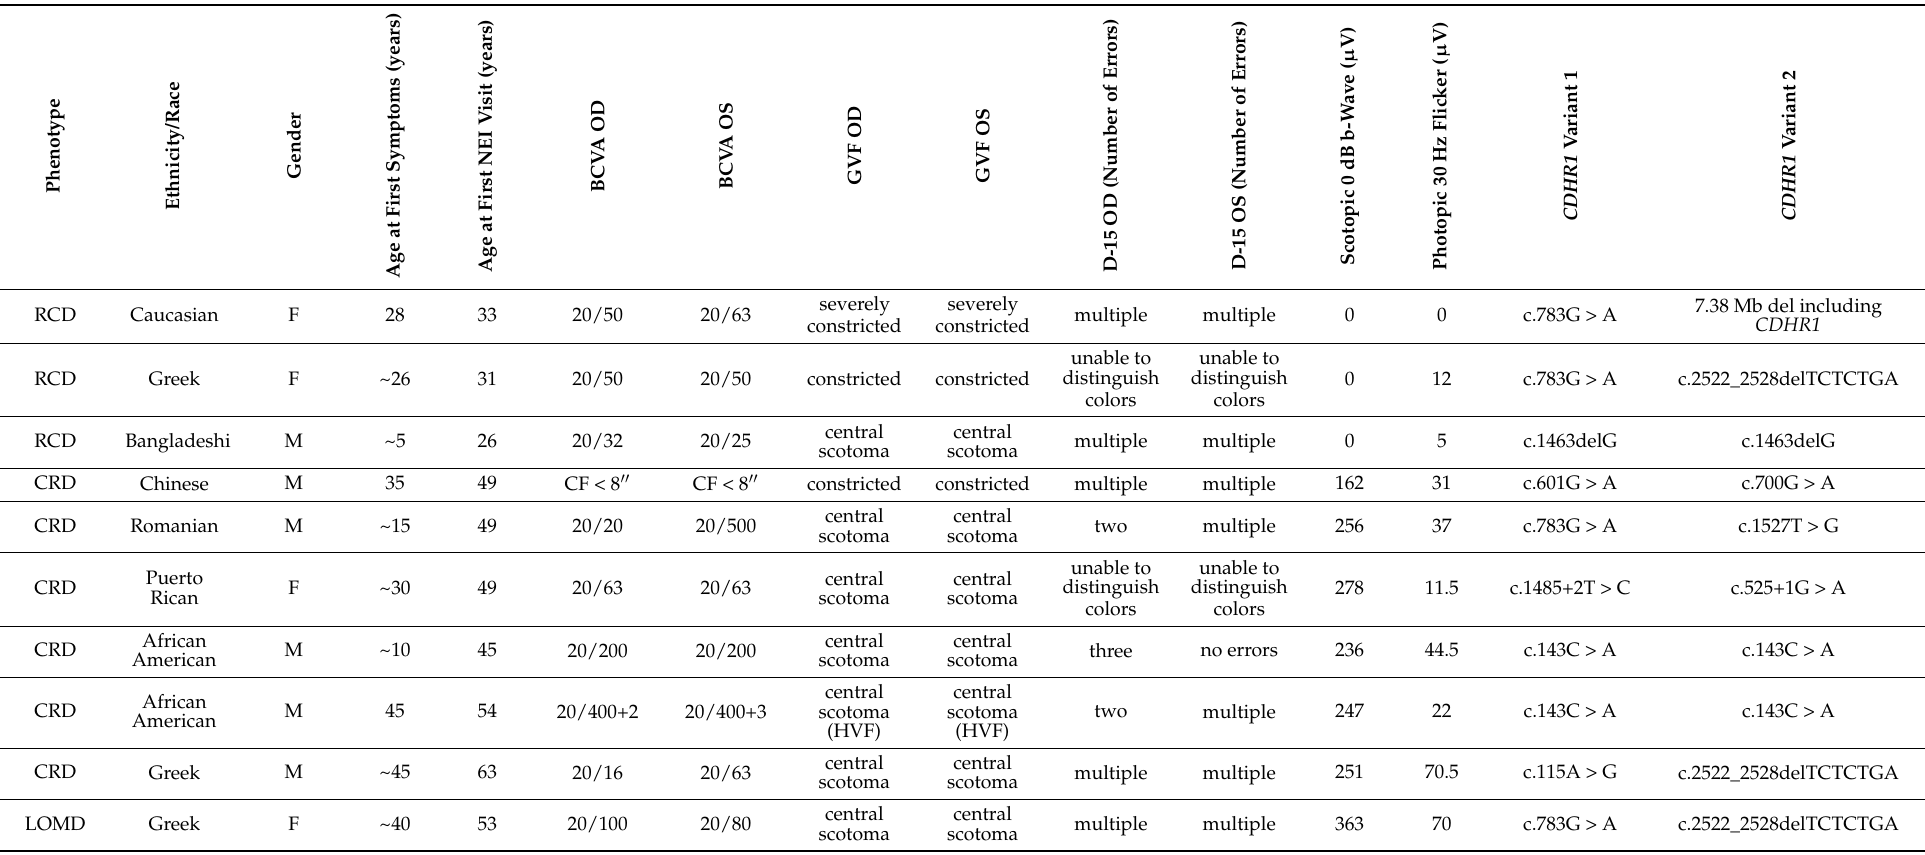
Table 2. Summary of clinical findings in our CDHR1 cohort. Each row in the table represents a single patient. Scotopic 0dB b-wave and photopic 30 Hz flicker ERG amplitudes are presented as an average value of ERG response amplitudes from the right and left eyes of each patient (lower limit of normal is 373 µ V for the scotopic 0 dB b-wave amplitude and 66 µ V for the photopic 30 Hz flicker ERG amplitude). RCD, rod–cone dystrophy; CRD, cone–rod dystrophy; LOMD, late-onset macular dystrophy; F, female; M, male; BCVA, best corrected visual acuity; OD, right eye; OS, left eye; CF, counting fingers; GVF, Goldmann visual field perimetry; HVF, Humphrey visual field perimetry; ERG,